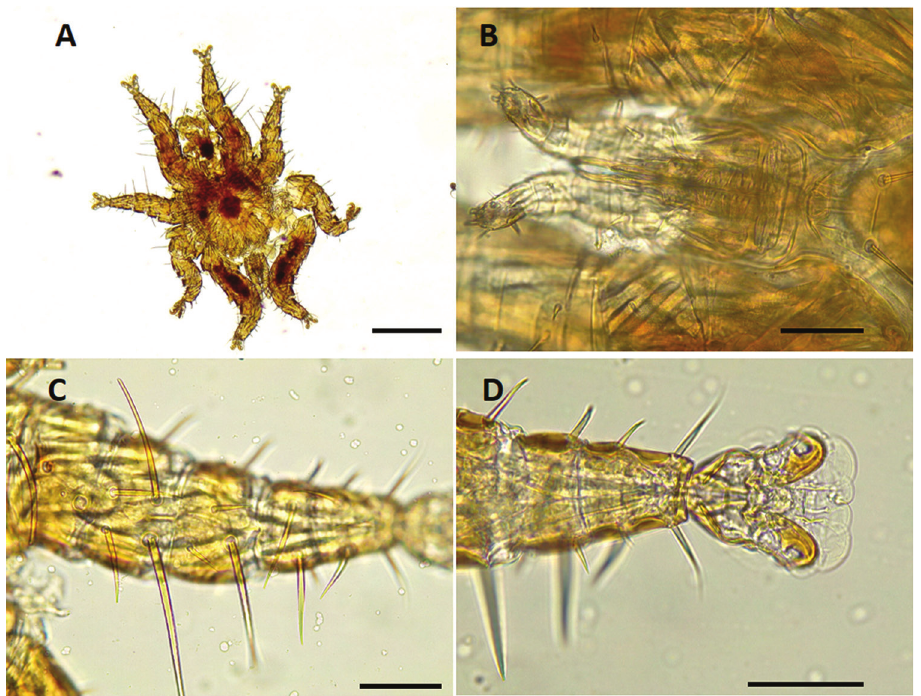
Figure 4. A specimen of Periglischrus vargasi , 40× magnification B detail of gnatossome, 400× C detail of setae insertion in the leg, 400× D distal detail of the leg, 400×. Leica DM500 optical microscope. Scale bars: 0.5 mm ( A ); 0.1 mm ( B–D ). Table 1. Number of hosts examined (N), infected (in parentheses), Prevalence (P), Mean Intensity (MI) and Mean Abundance (MA), with Confidence Intervals (CI 95%), for ectoparasites of Anoura geoffroyi in Piedade cave, located in Serra da Piedade, state of Minas Gerais. Inactive males had poorly developed testes and inactive females were those who did not show evidence of pregnancy and lactation. * = Signifi- cant